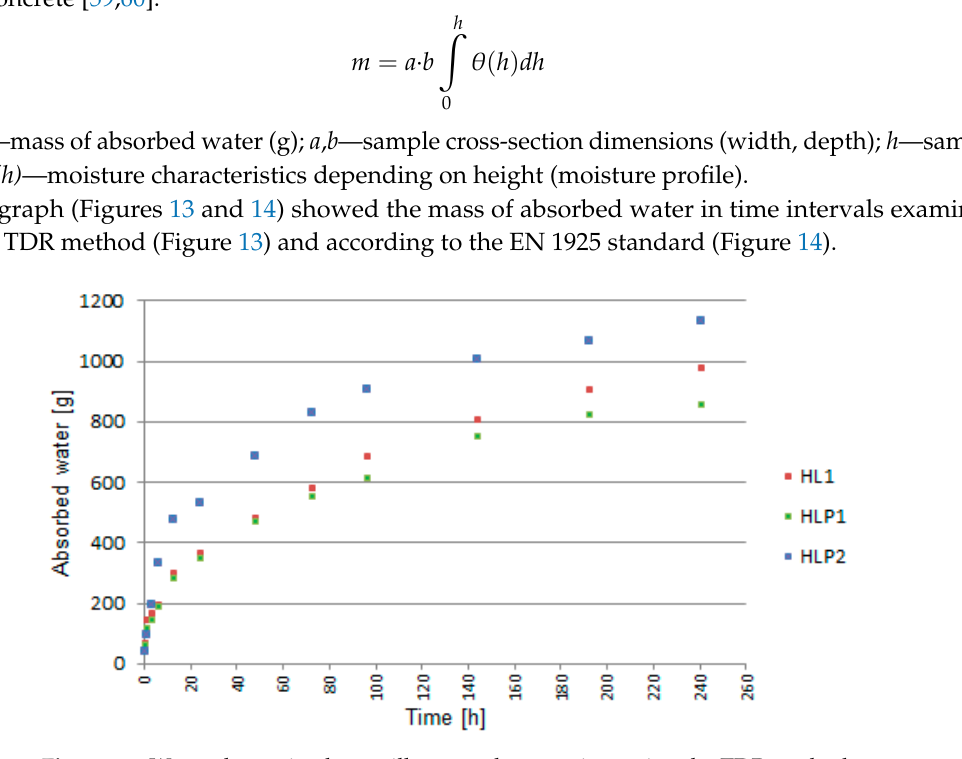
Figure 13. Water absorption by capillary uptake over time using the TDR method.